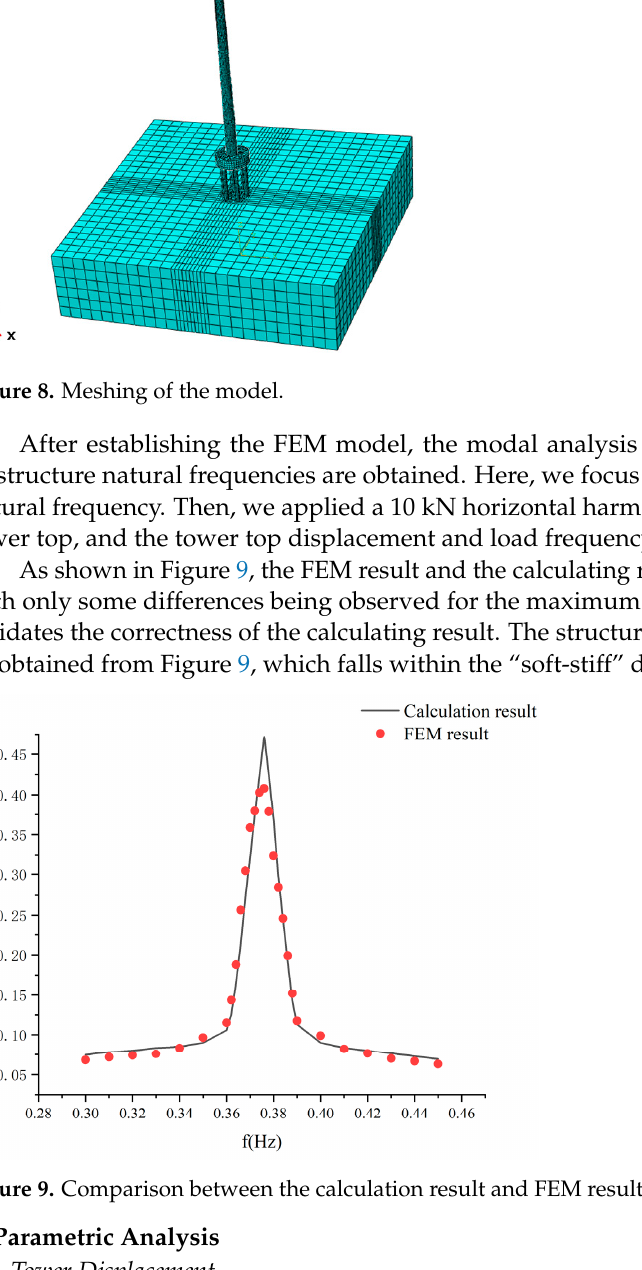
Figure 9. Comparison between the calculation result and FEM result.